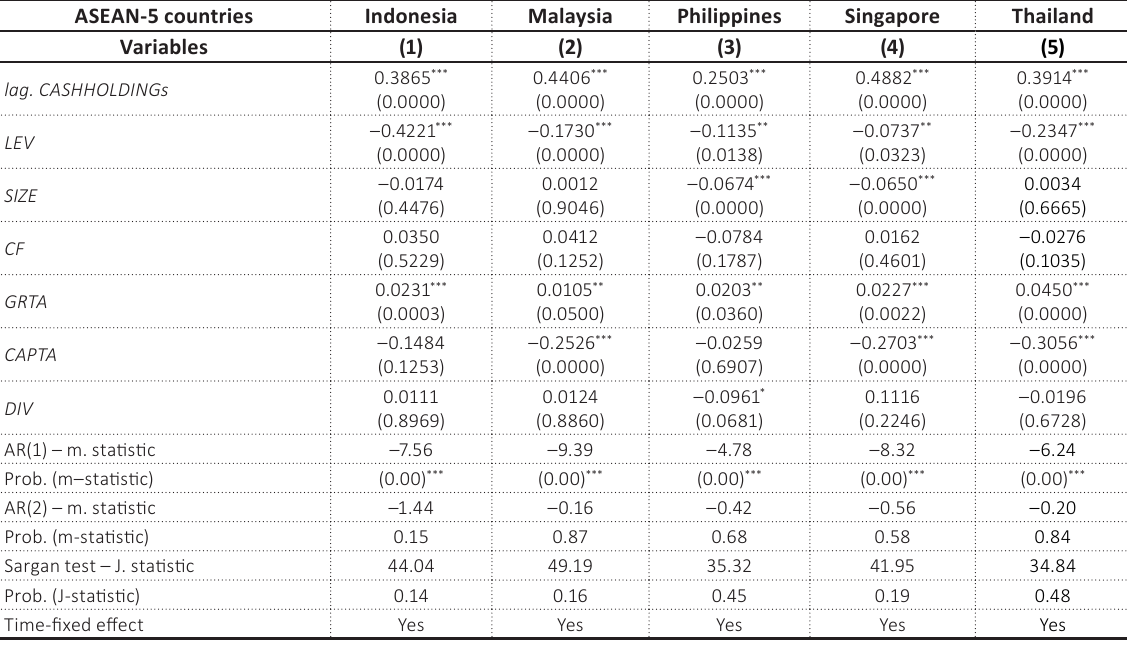
Table 7. Influence of debts and macroeconomic factors on corporate cash holdings in a dynamic model for each country of the ASEAN